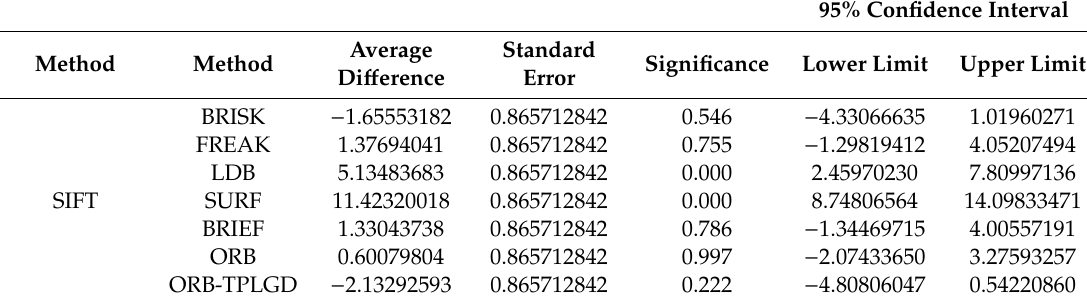
Table 12. Tukey test result for